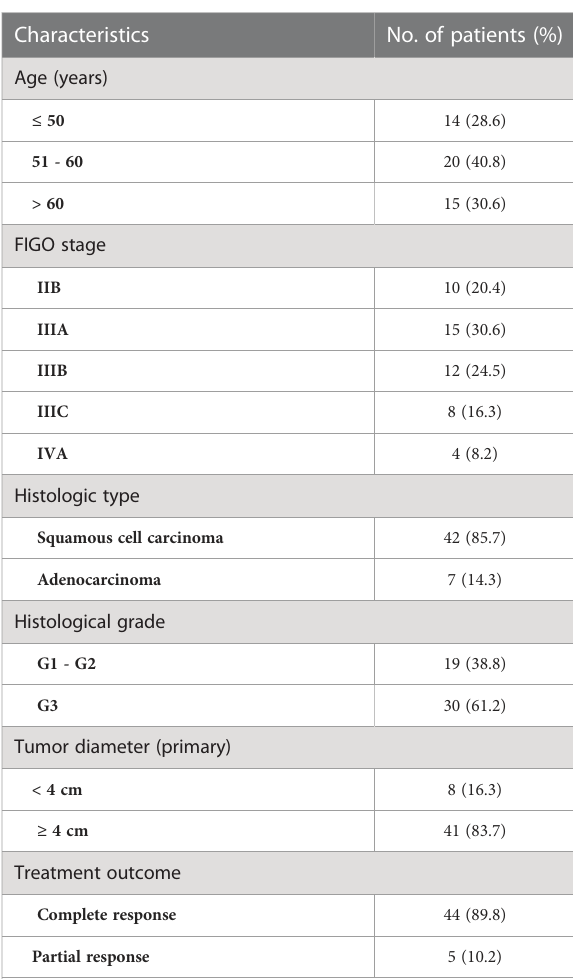
TABLE 1 Characteristics of the study